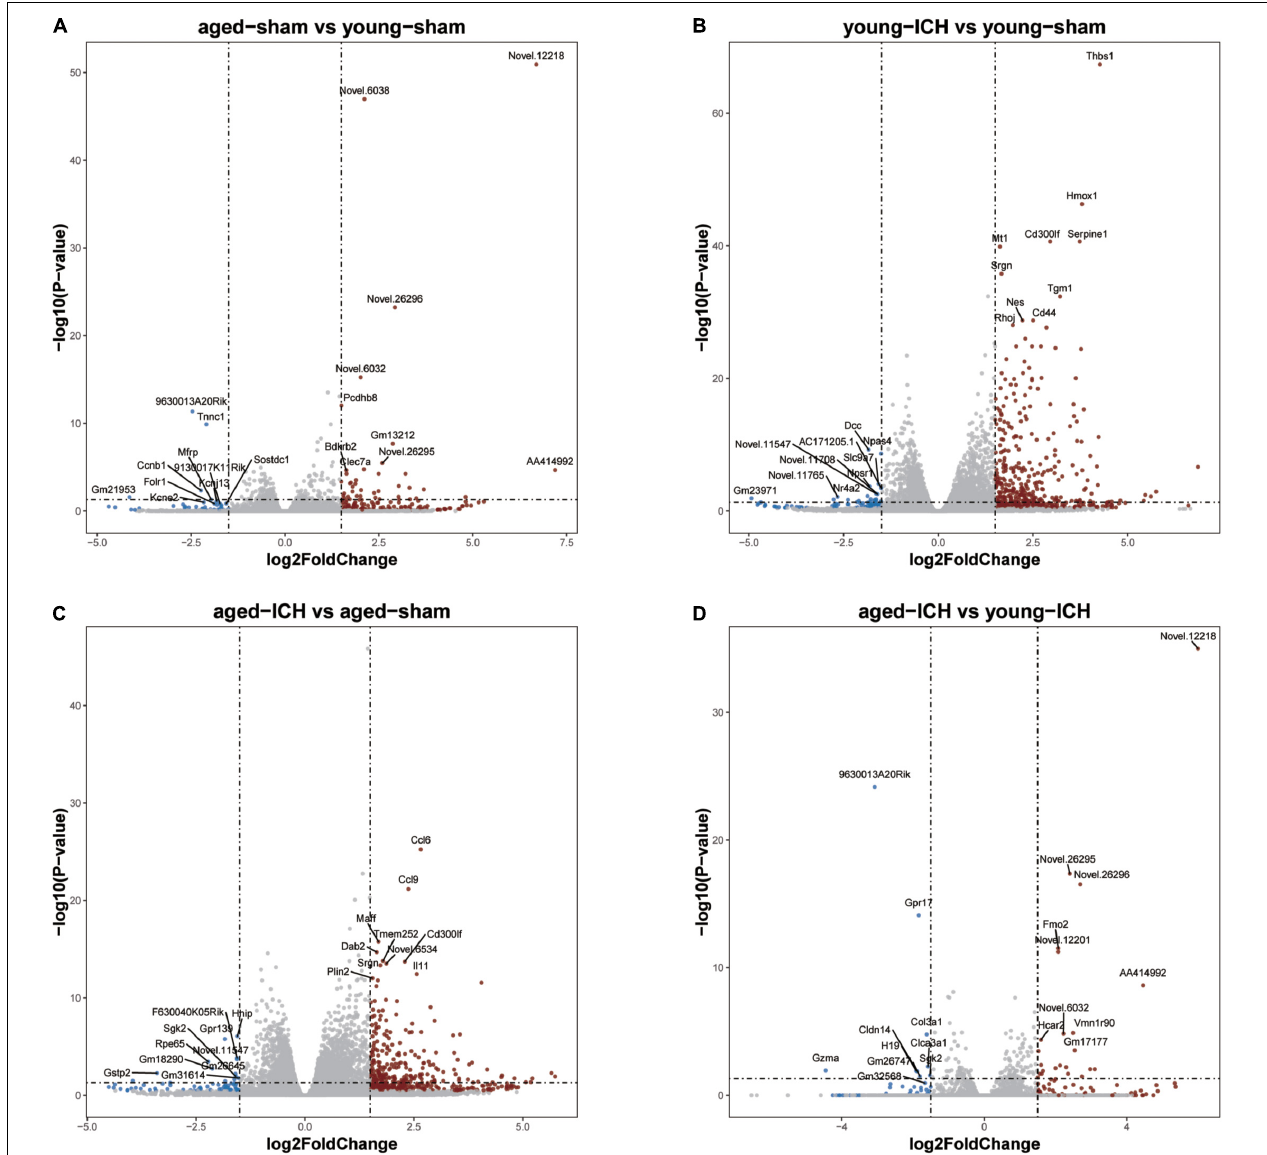
FIGURE 3 | Volcano plots of selected pairwise comparisons. The criterion for identification DEGs is FC > 1.5 or FC < 0.67, P < 0.05. (A) Young sham vs. aged sham. (B) Young ICH vs. young sham. (C) Aged ICH vs. aged sham. (D) Aged ICH vs. Young ICH. ICH, intracerebral